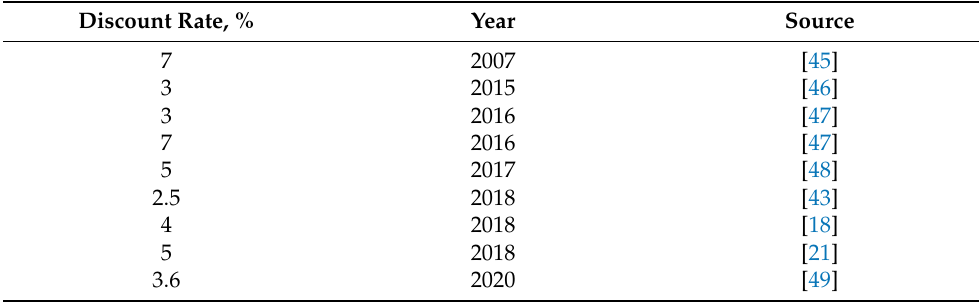
Table 5. Literature review of discount rates for the TCO analysis.